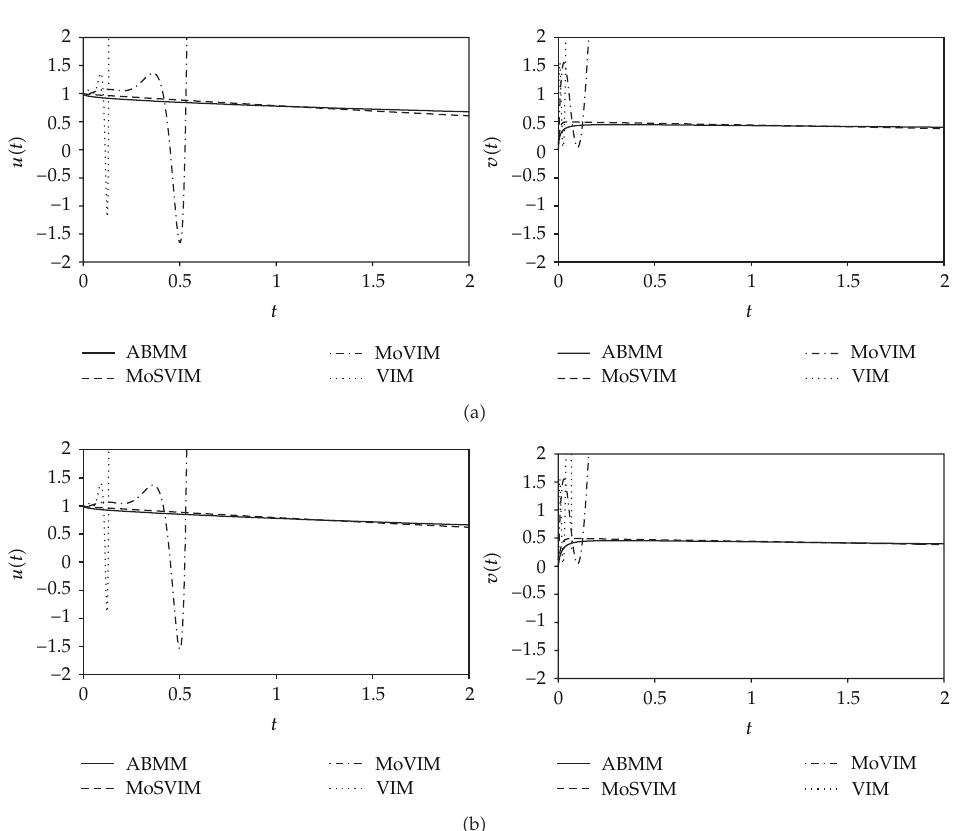
Figure 3: Approximatesolution of fractional biochemical reaction model via the fifth iterate MoSVIM, VIM, (cid:9) 0 . 25; (cid:3) a (cid:4) θ (cid:9) 0 . 7, (cid:3) b (cid:4) θ (cid:9) 0 . 8. MOVIM and ABMM with di ff erent value (cid:0)